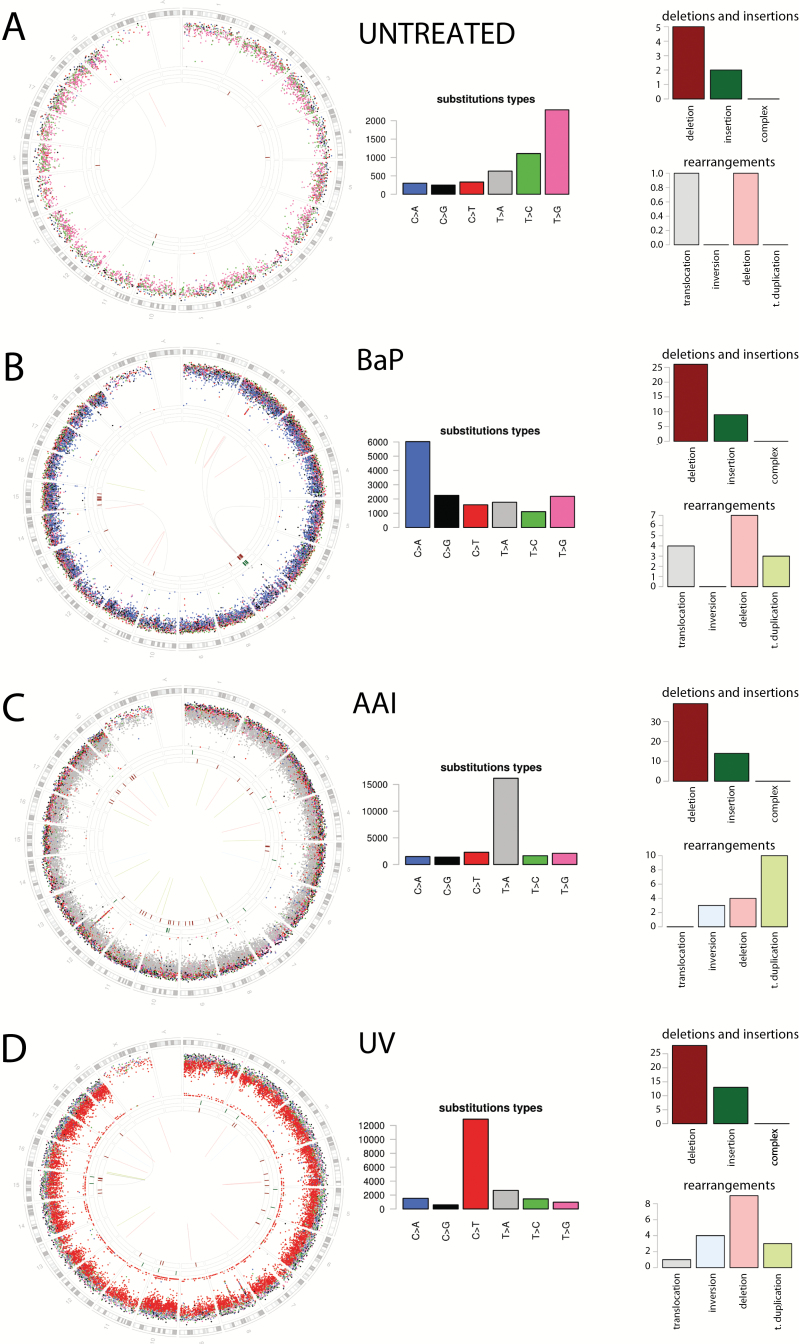
Whole-genome sequenced read-outs of four different Hupki MEF clones exposed to different mutagens demonstrate distinctive differences between clones. (A) from a clone of untreated cells, containing 4913 mutations; (B) from a clone of BaP-treated cells, containing 14929 mutations; (C) from a clone of AAI-treated cells, containing 25100 mutations; (D) from a clone of UV-irradiated cells, containing 20111 mutations. Features in Circos plots on left depict karyotypic ideogram outermost, then moving inwards: base substitutions, plotted as rainfall plots (log10 intermutation distance, dot colours: blue = C>A, black = C>G, red = C>T, grey = T>A, green = T>C, pink = T>G). Ring with short green lines = insertions, ring with short red lines = deletions. Central line: grey = intrachromosomal rearrangements, pink = deletions, green = tandem duplications. Histograms in the centre show substitution types. Histograms on right show deletions and insertions (upper) and rearrangements (lower). The y-axis of each histogram indicates the number of mutations. Enlarged versions of the Circos plots can be viewed in Supplementary Figures 2–5.